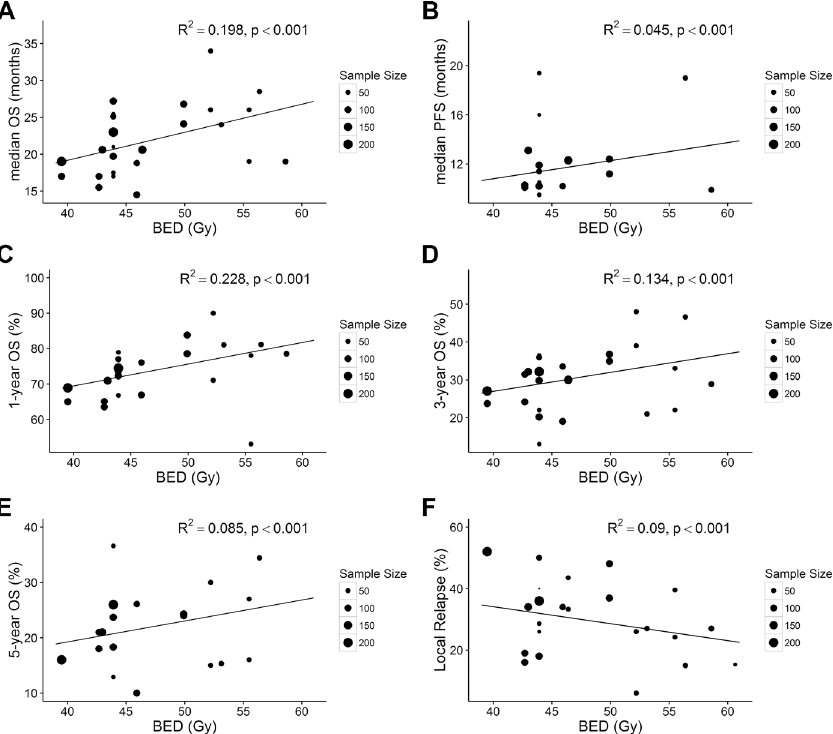
Fig 2. Association between BED and mOS (A), mPFS (B), 1-year OS (C), 3-year OS (D), 5-year OS (E), and LR (F) for all included studies. Each point in the plot represents a value of one arm. The point size represents the sample size. All analyses were conducted by linear regression methods weighted by sample size. BED , biological effective dose; mOS , median overall survival; 1-, 3-, 5-year OS , 1-, 3, 5-year overall survival; LR , local